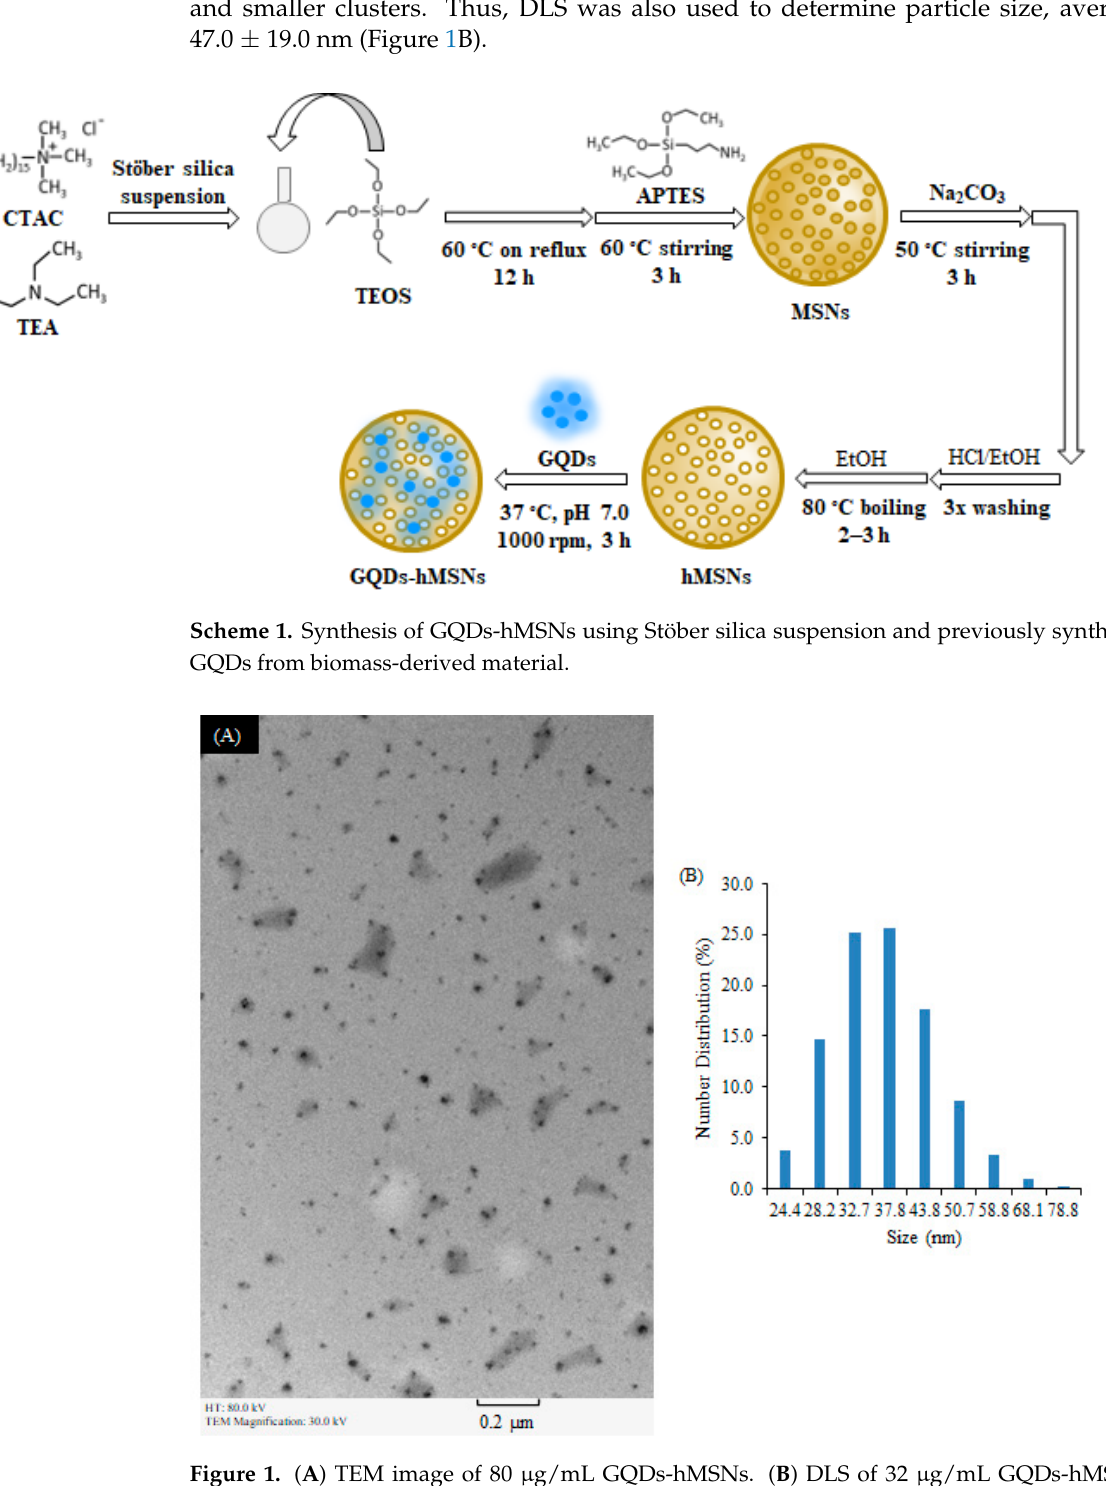
Figure 1. ( A ) TEM image of 80 µg/mL GQDs-hMSNs. ( B ) DLS of 32 µg/mL GQDs-hMSNs in DI-water after 5 min sonication.